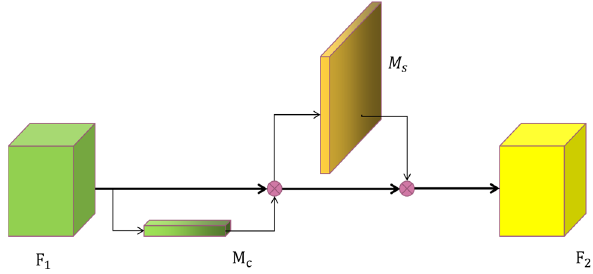
Figure 6. The mixed-domain attention mechanism CNAM.